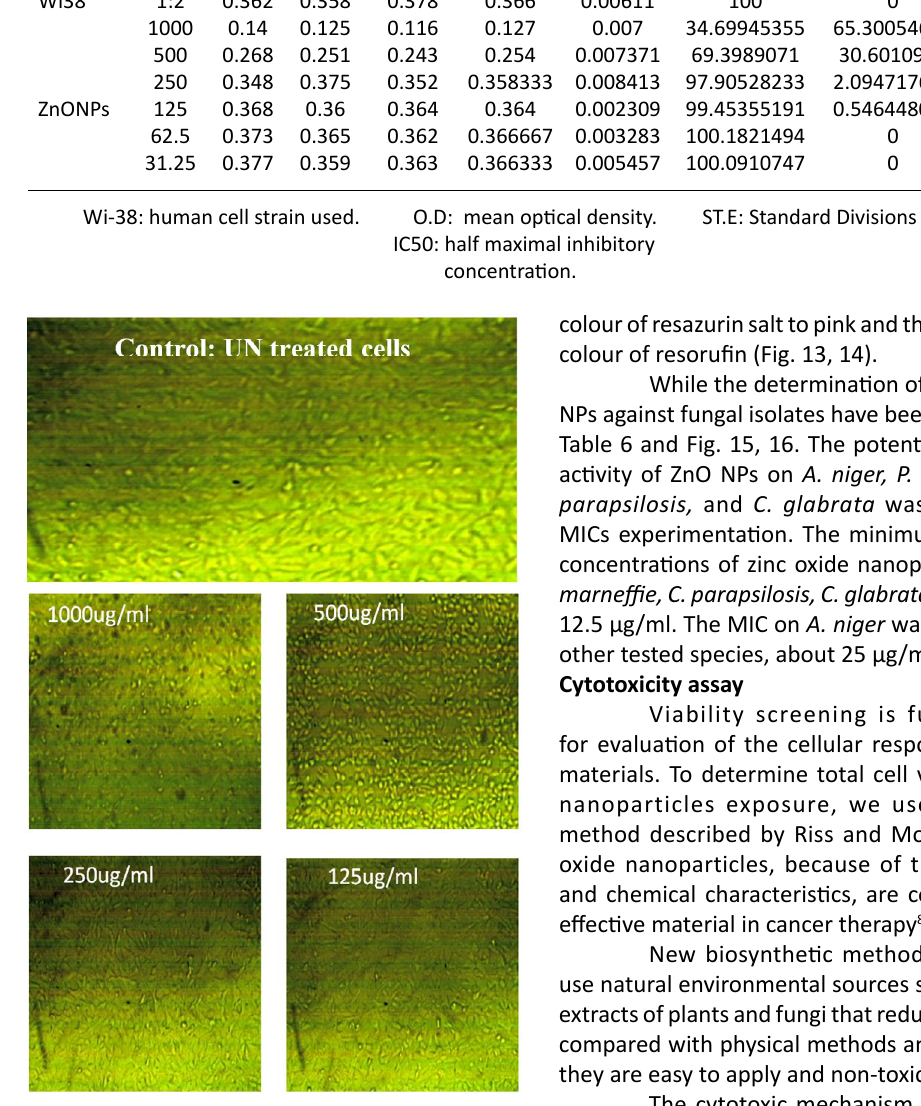
Fig. 18. Effect of ZnONPS on wi38 cells (Homo sapiens, lung, fibroblast, adherent and normal) at different